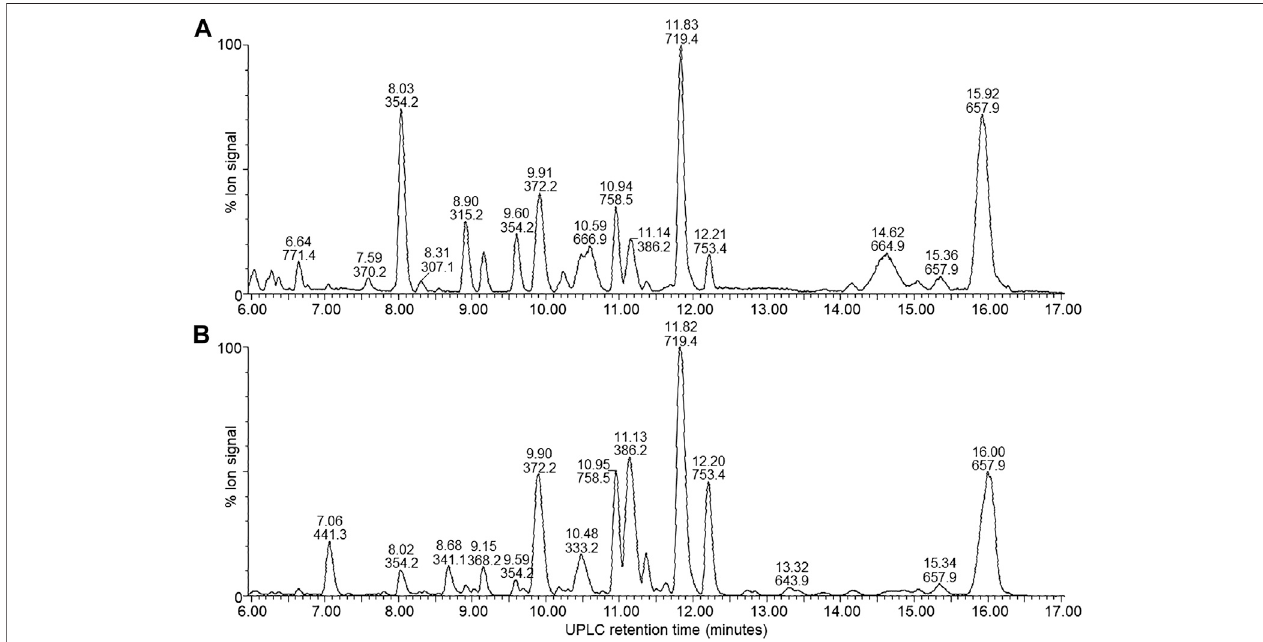
FIGURE 4 | UPLC-MS of the mid-gradient eluting components (6 – 17 min) from the four X. khoisanae J194 extracts that showed antibacterial activity: (A) NAO fractionofnonaeratedcultureinbroth, (B) extractfromculturegrownonsurfaceofsolidmedia.Themassesinthespectraareprotonatedmassesofthemostprominent detected